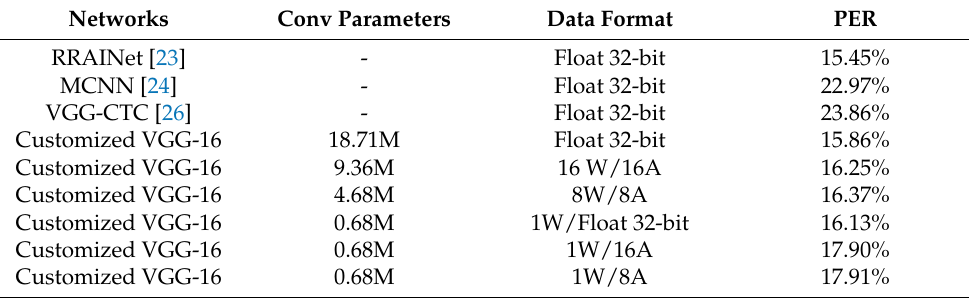
Table 2. Accuracy of customized VGG-16 and other networks on ST